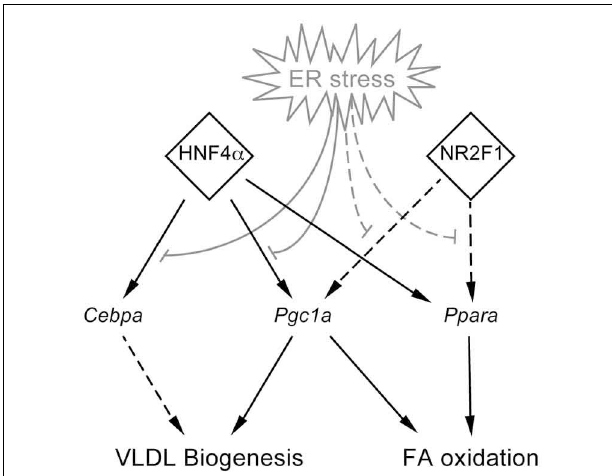
FIGURE 8 | Model for organization of lipid metabolic gene regulation during ER stress. Experimentally demonstrated (here or elsewhere) relationships are shown using solid lines, while as-yet unvalidated relationships suggested by this work are shown by dashed lines.